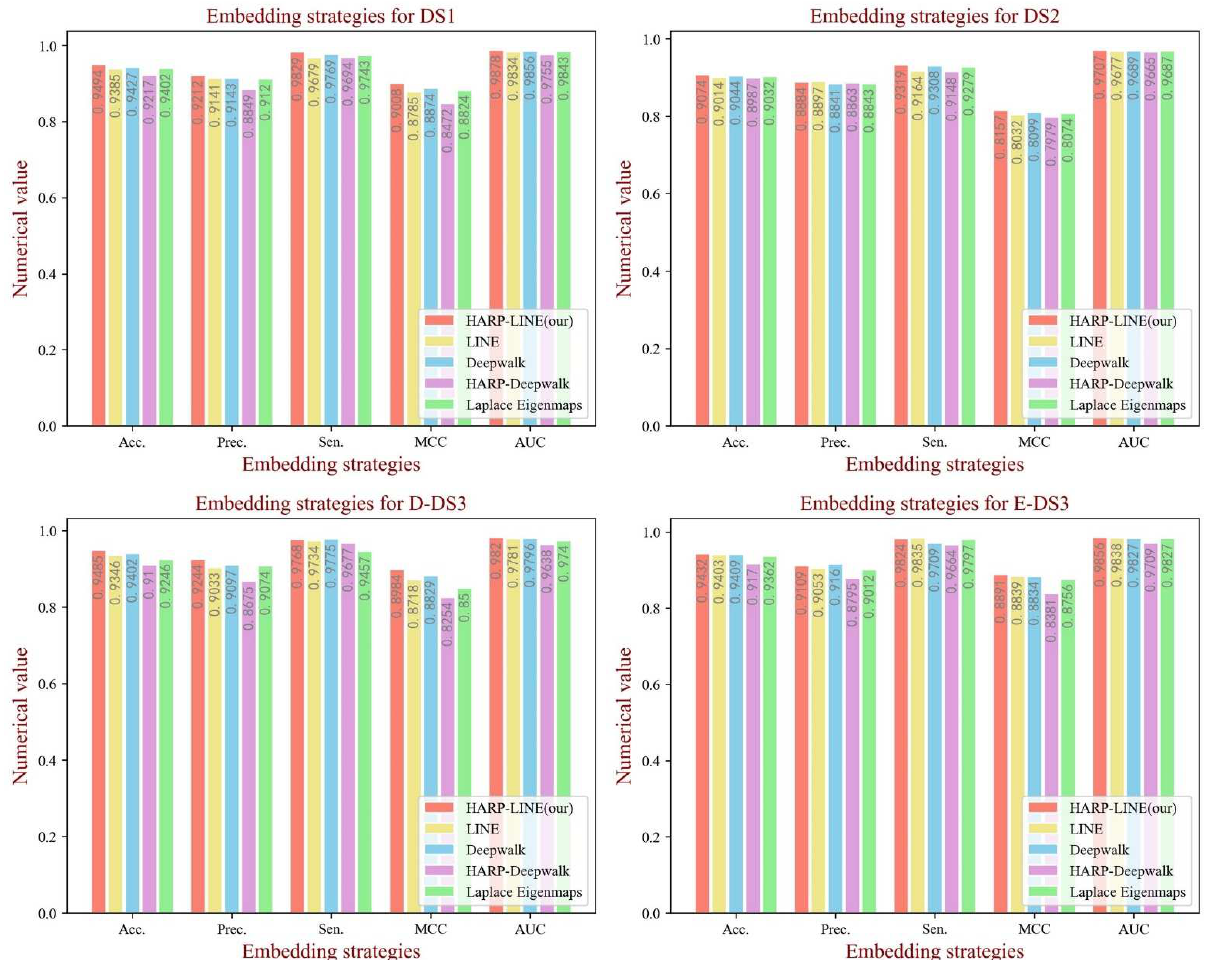
Figure 7. The performance of different graph embedding methods on each